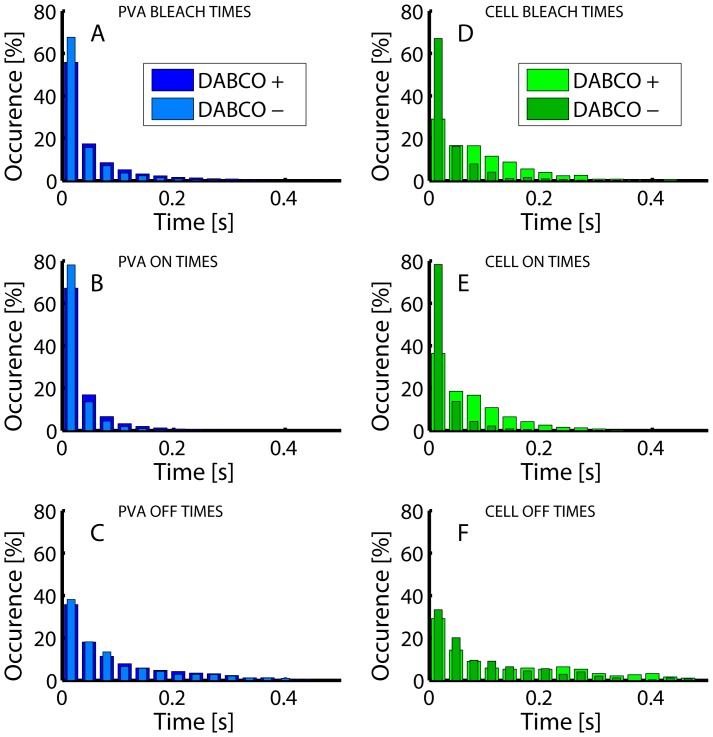
Representative histograms of Nbleach, Non, Noff from in vitro and in vivo Dendra2 photophysics.
A–C: PVA-embedded Dendra2 in the absence and in the presence of 10 mM DABCO; D–F: Fixed Vero cells expressing Dendra2-actin, in the absence and in the presence of 10 mM DABCO.